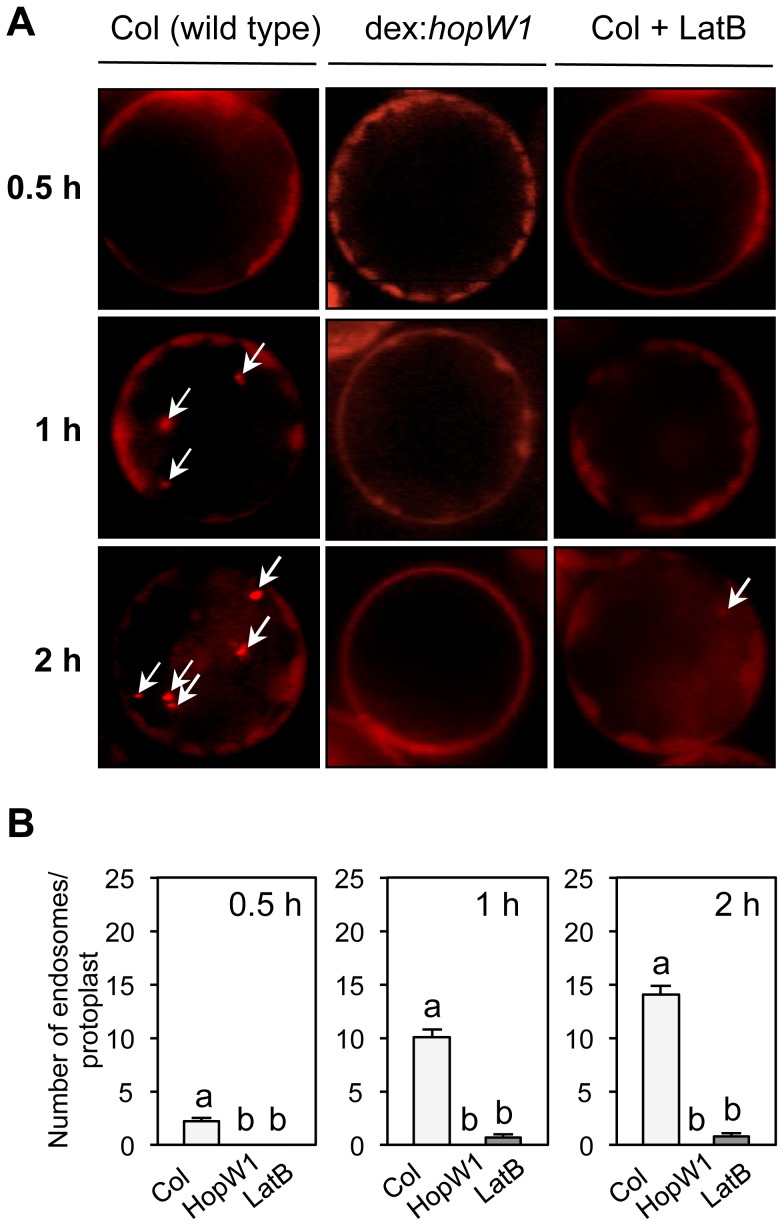
Endocytosis inhibition by HopW1 in Arabidopsis.(A) Representative microscopic images that show the effects of HopW1 and LatB on endocytic vesicle formation. Wild-type and dex:hopW1 Arabidopsis Col protoplasts were treated with 0.2 µM dexamethasone, stained with FM4-64 and visualized by fluorescence microscopy. 10 µM LatB was used to disrupt the actin cytoskeleton. After over-night incubation with dexamethasone and/or LatB, protoplasts were labeled with FM4-64 and viewed after 0.5, 1 and 2 h. Arrows point to some of the FM4-64-stained endosomes. Protoplasts from two independent transgenic dex:HopW1 lines were used with similar results. (B) Endosomes were quantified in protoplasts from the indicated plants that were treated and stained as in (A). At least 20 protoplasts per treatment, per time-point, from three biological repeats (independent experiments) were analyzed. Bars indicate SEM. Different letters indicate significantly different numbers of endosomes (P<0.0001) between wild type versus dex:hopW1 or LatB-treated wild type, determined using ANOVA/Tukey's test.